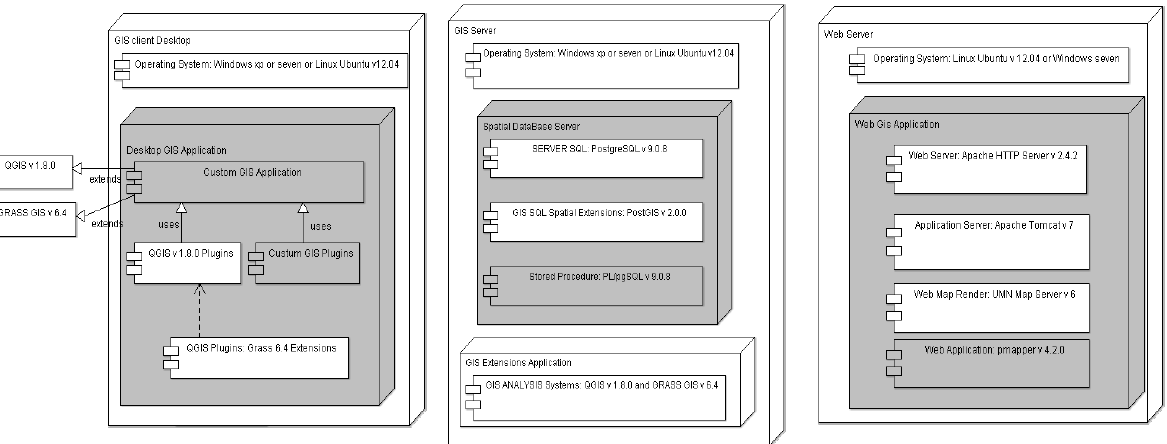
Figure 4. Deployment diagram related to GIS